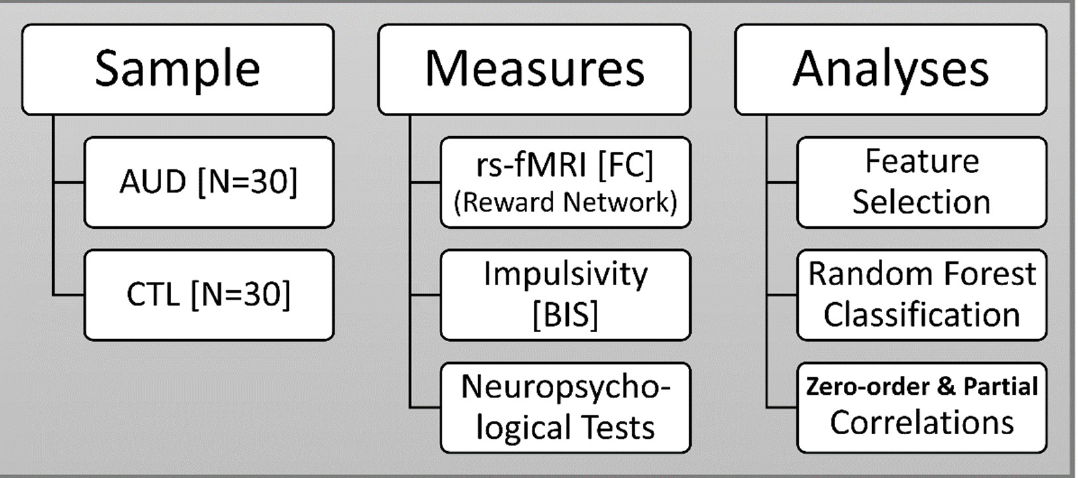
Figure 1. The study protocol listing the sample, measures, and analytic techniques. The sample con- sisted of two groups of 30 individuals each, viz., AUD and CTL. The measures used in the prediction model included rs-fMRI functional connectivity (reward network), impulsivity assessed with Barratt impulsiveness scale (BIS), and neuropsychological performance scores. Major analyses were features selection for selecting FC variables, random forest classification method, and correlational analyses, including zero-order and partial correlations.